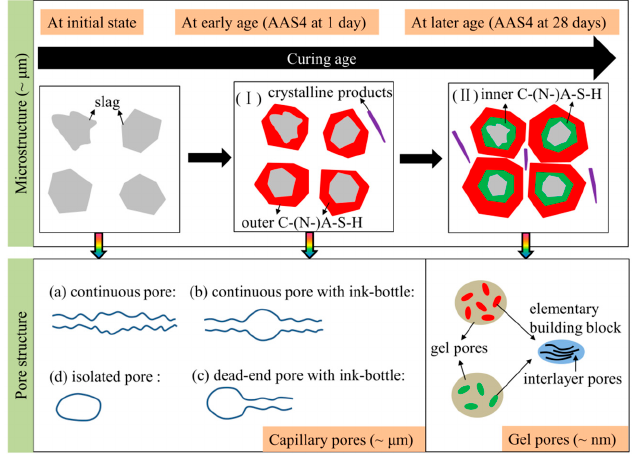
Figure 14. Schematic illustration of the microstructure formation and pore structure of sodium hydroxide activated slag samples.